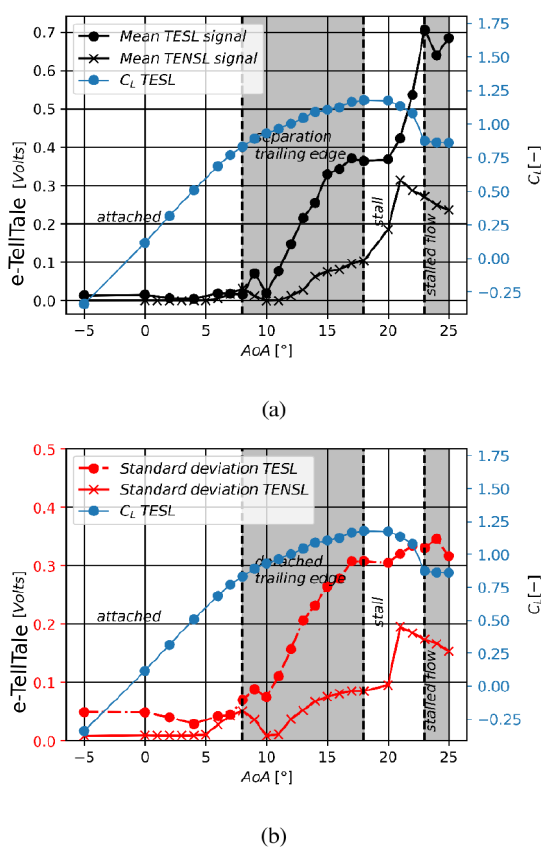
Figure 13. Comparison of the mean (a) and the standard devia- tion (b) of the signal of the TESL and TENSL e-TellTale sensors as a function of